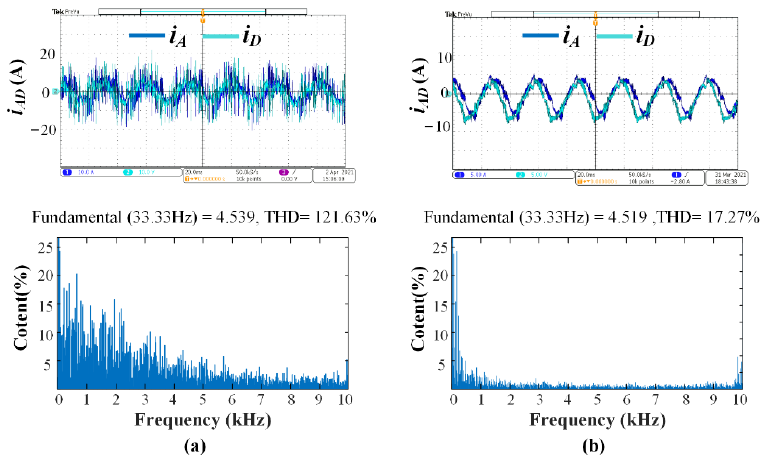
Figure 14. FFT analysis of phase current for both methods with 5N.m load. ( a ) Conventional VV-MPC; ( b ) proposed MVV-MPC.